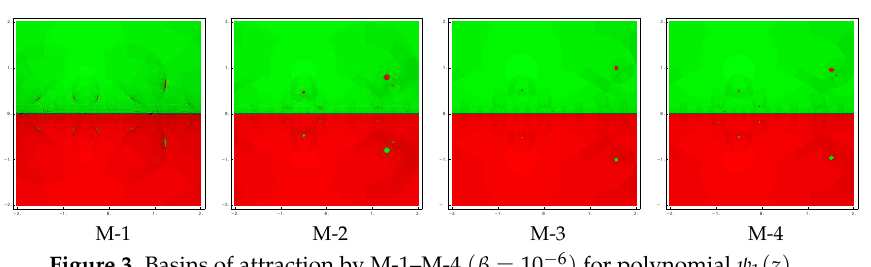
Figure 2. Basins of attraction by M-1–M-4 ( β = 10 − 4 ) for polynomial ψ 1 ( z ) .